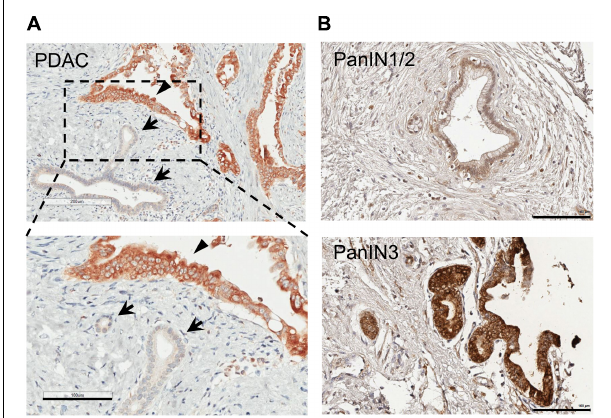
FIGURE 2 | MSP expression in human pancreatic cancer tissues and tissue micro array (TMA). IHC staining of human pancreatic tissues using anti-MSP antibody. (A) PDAC. Note that MSP can be detected in cancer cells (arrowheads) but not in normal or un transformed ductal epithelial cells (arrows). (B) Representative images of TMA with PanIN1/2 or 3. Magnification: 20 × ; Scale bar: 100 µ m.